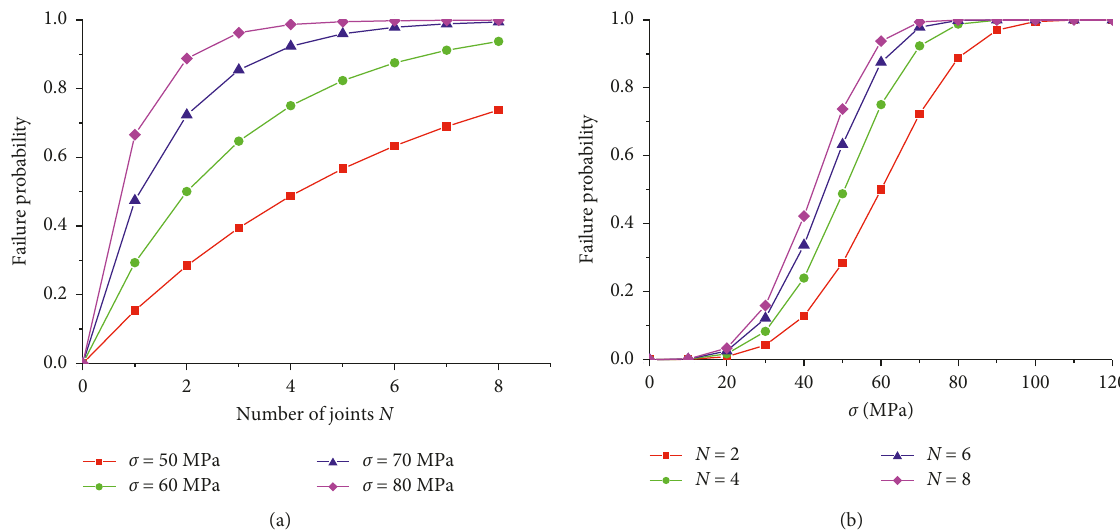
Figure 6: Failure probability under different joint number N and stress σ conditions. (a) Failure probability for different number of joints N . (b) Failure probability under different stress conditions σ